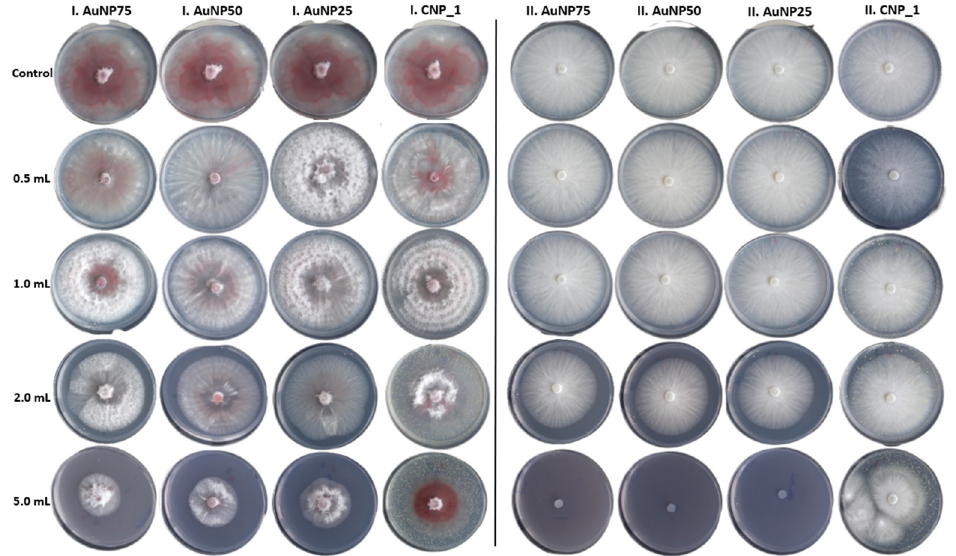
Figure 5. Effects of the interactions of different nanoparticles at different concentrations and doses on the inhibition of mycelial growth of two F. oxysporum strains. There was no inhibition in the case of the control plates. I— F. oxysporum , DSM 62338 strain; II— F. oxysporum , DSM 62060 strain. For all the controls, the same picture was used as there was no difference between the control plates.